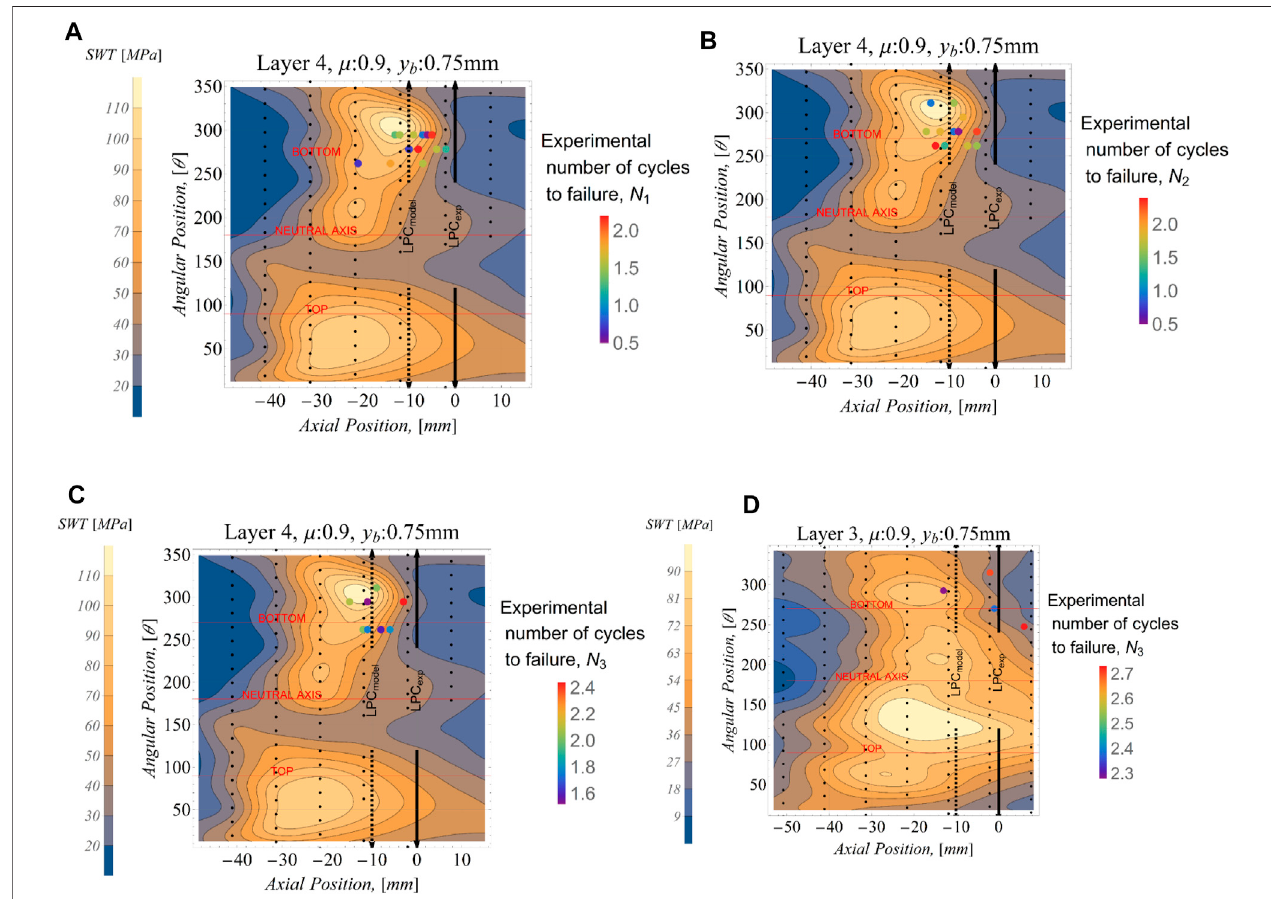
FIGURE 10 | Location and number of cycles of Experimental Observation of Levesque Levesque (2005): (A) fi rst wire failure, (B) second wire failure, (C) third wire failure on layer 4, and (D) third wire failure on layer 3; all for a bending amplitude of 0.75 mm. Indicated number of cycles are in millions (10 6 ).